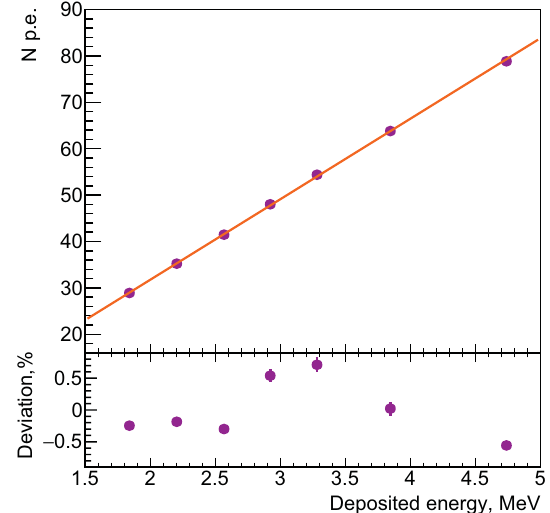
Figure 5. Number of p.e. detected with SiPMs vs energy deposited by cosmic muons in a scintillator strip (top) and the deviation from a straight line fit (bottom). Different muon energies correspond to different crossing angles of the muons and the strips.